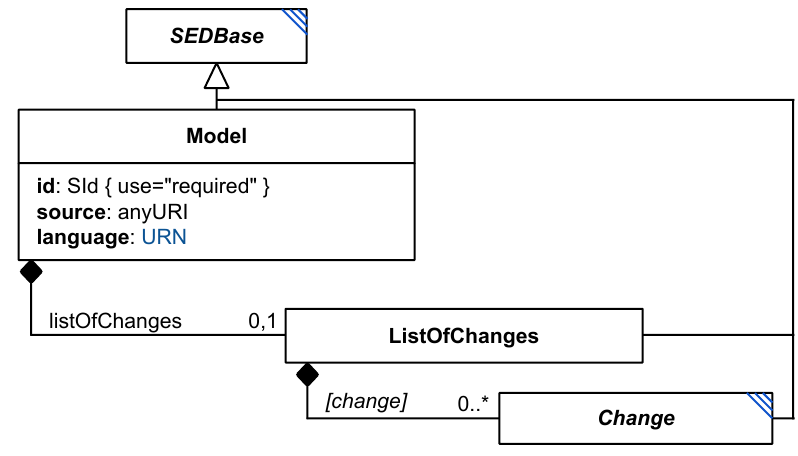
Figure 2.9: The SED-ML Model